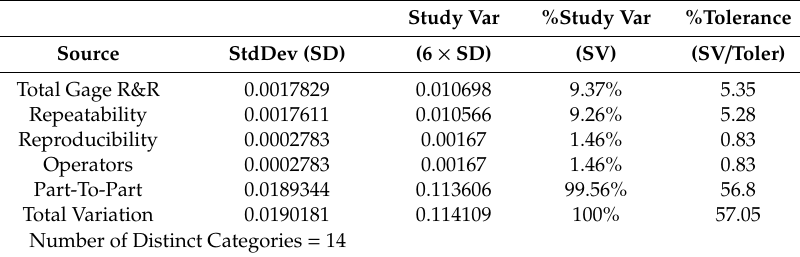
Table 3. Gage evaluation for diameter (D).